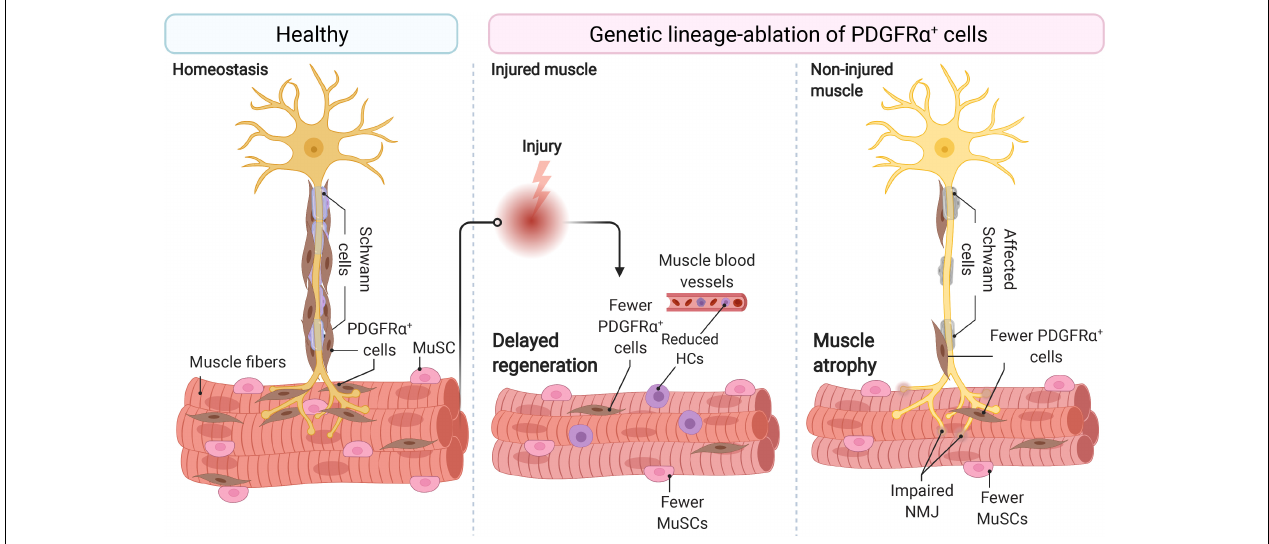
FIGURE 1 | Fibro-adipogenic progenitors are essential and required for efficient skeletal muscle regeneration and homeostatic neuromuscular integrity. Skeletal muscle FAPs are abundant stromal cells, reside within the connective tissue, and lie near the nerve parenchyma and NMJs in healthy muscles and homeostatic conditions. Conditional ablation of FAP+ cells using diphtheria toxin resulted in delayed regeneration and reduced numbers of MuSCs and HCs. In homeostasis and non-damaged muscles, widespread ablation of FAPs causes muscle atrophy, impair Schwann cell, and MuSC behavior and abundance. Impaired NMJ architecture and partial and complete muscle denervation also result from FAP cell ablation without damage. MuSC, muscle stem cell; HCs, hematopoietic cells; NMJ, neuromuscular junction. Motoneuron and Schwann cells are not shown in the middle panel because of space constraints and improved